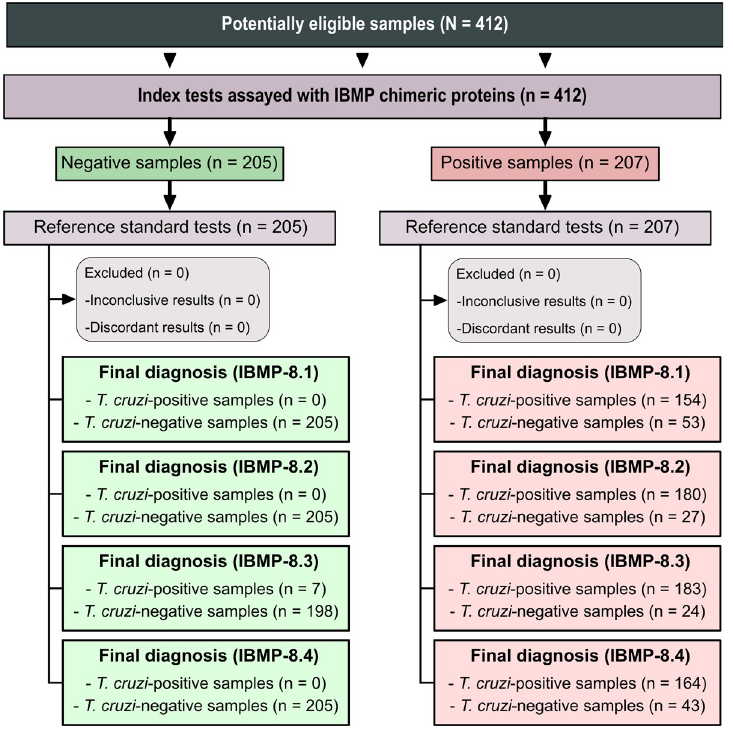
Fig 1. Flowchart illustrating study design in accordance with the Standards for Reporting of Diagnostic Accuracy Studies (STARD) guidelines.